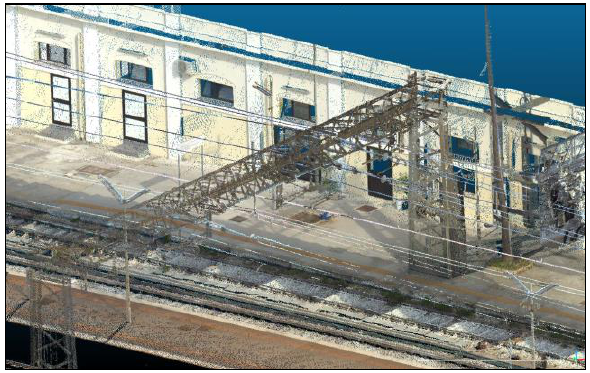
Figure 5 - point clouds from train telemetry laser scanner.